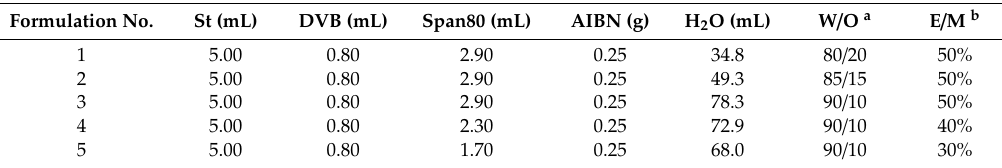
Table 1. Preparation parameters of the polyHIPE Scaffolds.